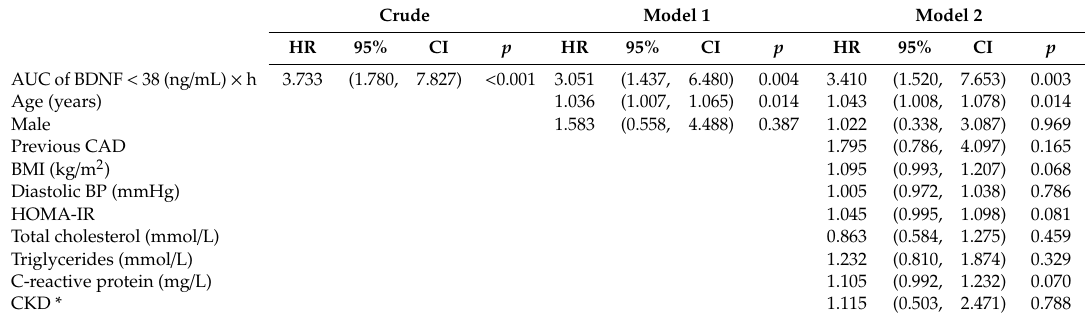
* Chronic kidney disease (CKD) = estimated glomerular filtration rate < 60 mL / min / 1.73 m 2 . AUC =